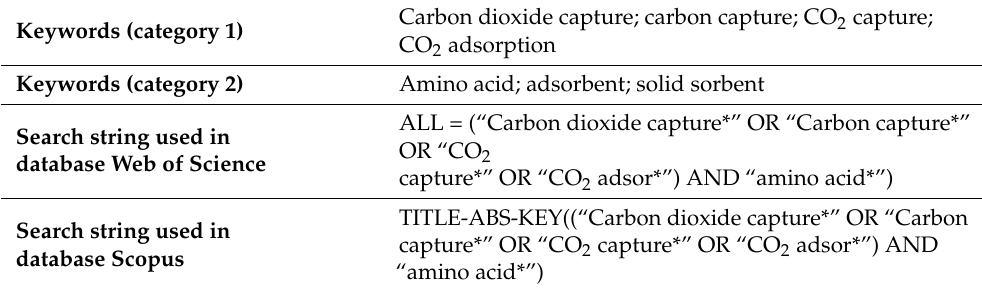
Table 3. Selection of keywords and search string for literature